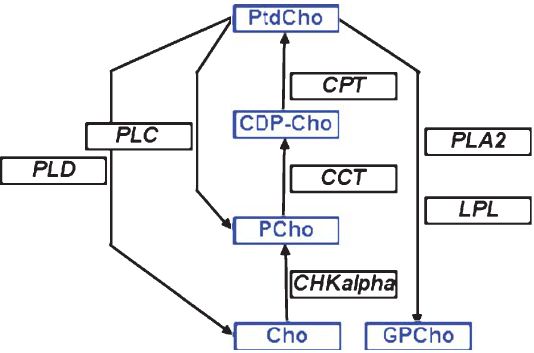
Fig. 1. Schematic diagram showing biosynthetic and catabolic pathways of phosphatidylcholine (PtdCho) metabolism. Metabolites are reported in blue with the following abbreviations: PtdCho, phosphatidylcholine; CDP-Cho, cytidine diphosphate choline; PCho, phosphocholine; Cho, choline;GPCho,glycerophosphocholine.Enzimesarereportedinblack:PLD,phospholipaseD(EC:3.1.4.4);PLC,phospholipaseC[EC:3.1.4.3]; CPT, choline phosphotransferase [EC:2.7.8.2]; CCT, choline-phosphate cytidylyltransferase [EC:2.7.7.15]; CHK-alpha, choline kinase alpha [EC:2.7.1.32]; PLA2, cytosolic phospholipase A2 [EC:3.1.1.4]; LPL, lysophospholipase I